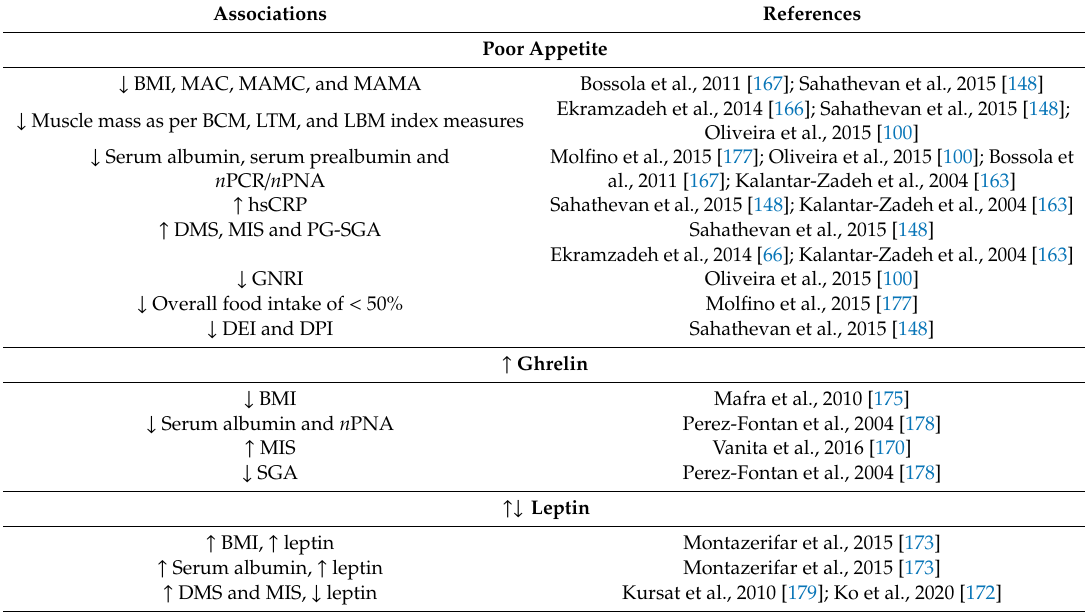
Table 7. Nutritional outcomes associated with anorexia and appetite hormones in HD patients.